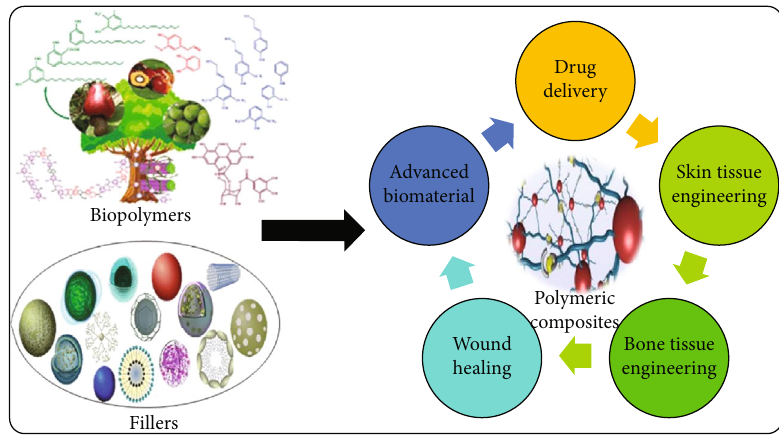
Figure 2: Potential applications of biopolymers in di ff erent aspects [38].